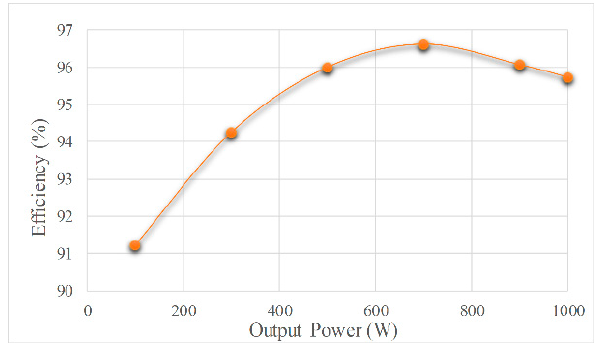
Figure 18. Loss contribution of the proposed converter at rated load. Figure 19. Efficiency curve under different output power.